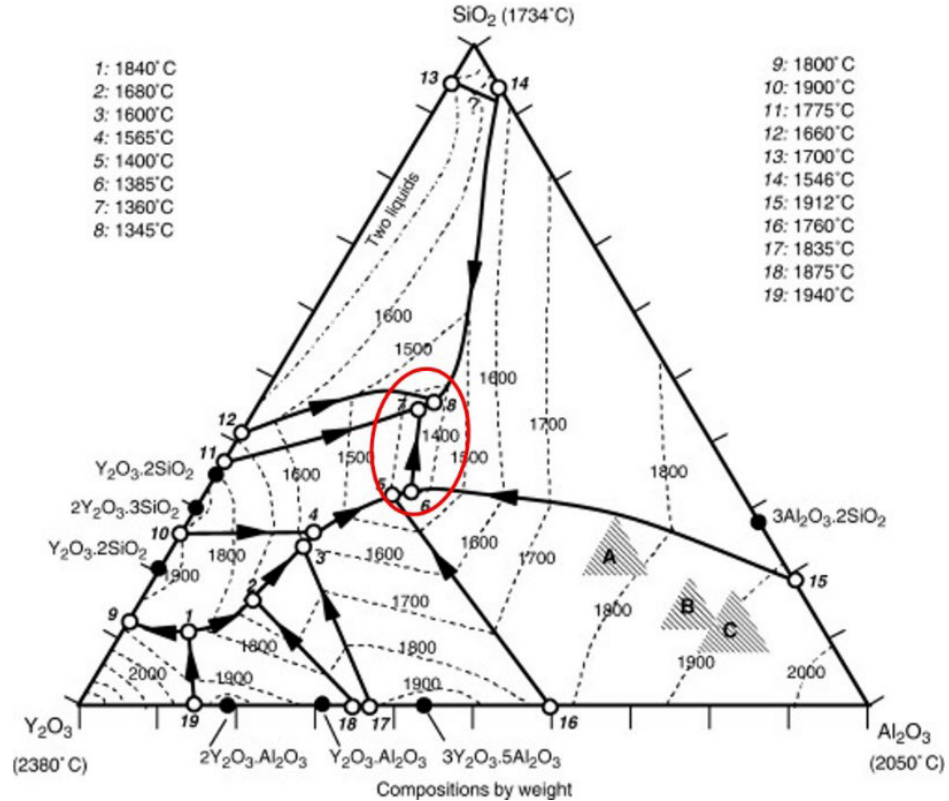
Figure 9. Y 2 O 3 –Al 2 O 3 –SiO 2 ternary phase diagram.